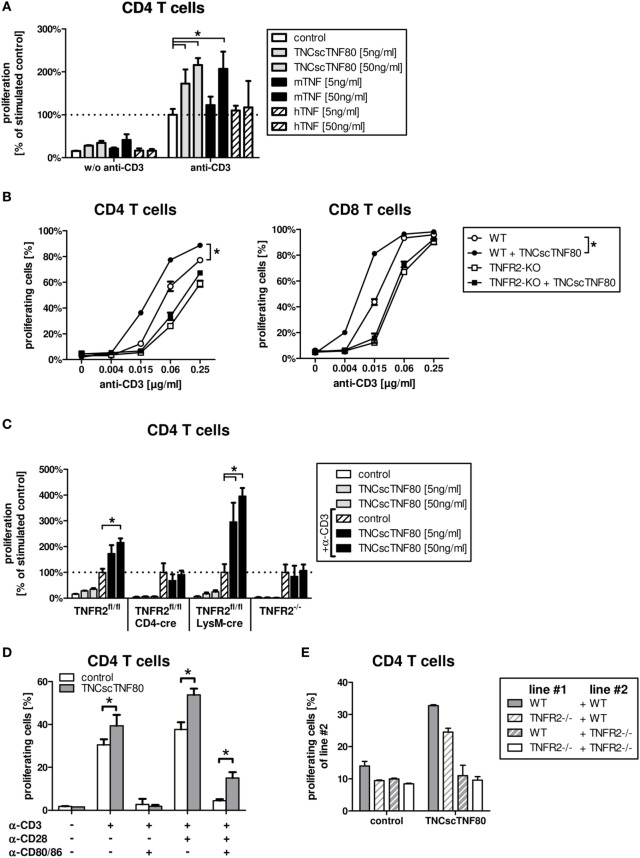
TNCscTNF80-increased proliferation in vitro. The relative proliferation of stimulated CD4 T cells from WT mice without or with 5 or 50 ng/ml of either TNCscTNF80, mouse TNF, or human TNF is shown. Data are relative to anti-CD3ε-activated T cells without any TNF variant. (A) The proliferation of CD4 (left) or CD8 (right) T cells from either WT (round symbols) or TNFR2-deficient (square symbols) mice is shown in the presence (filled symbols) or absence (empty symbols) of TNCscTNF80 (10 ng/ml) and increasing concentrations of stimulating anti-CD3ε antibodies. Data shown are mean + SD of culture replicates from one representative experiment of five. For statistical analysis, the area-under-the-curve was calculated for all five experiments, and the combined data were analyzed. (B) The relative proliferation of stimulated CD4 T cells from different mouse lines without or with 5 or 50 ng/ml of TNCscTNF80 is shown. For each mouse line, proliferation was calculated relative to the respective control of anti-CD3ε-activated T cells without TNCscTNF80 (C). Purified CD4 T cells from WT mice were stimulated with various combinations of anti-CD3ε (0.5 µg/ml), anti-CD28 (2.5 µg/ml) antibody, and blocking anti-CD80/CD86 antibodies (10 µg/ml). The proliferation of CD4 T cells cultured with or without TNCscTNF80 (10 ng/ml) is shown (D). Splenocytes from WT and TNFR2-deficient mice were split in two parts, one labeled with carboxyfluorescein succinimidyl ester (CFSE) and one unlabeled. Unlabeled splenocytes (line #1) were combined with CFSE-labeled splenocytes (line #2) at a ration of 1:1 and stimulated with anti-CD3ε antibody. The proliferation of CFSE-labeled CD4 T cells (line#2) in the presence or absence of TNCscTNF80 (10 ng/ml) is shown (E). For panels (A,C–E), mean + SD of culture replicates from one out of two independent experiments is given.